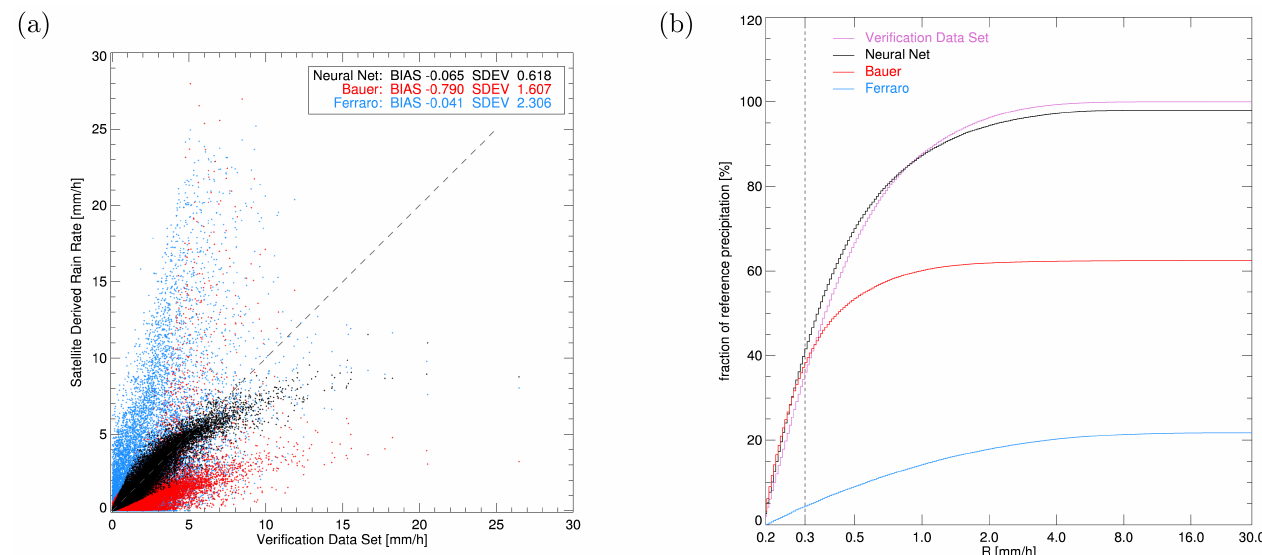
Figure 13. Comparison of di ff erent precipitation algorithms. (a) shows the retrieved precipitation rates of the neural network algorithm (black), the Bauer and Schl¨ussel (1993) algorithm (red) and the Ferraro (1997) algorithm (blue) against the precipitation rates from the verification data set. (b) shows the accumulated histogram of precipitation as the fraction of total precipitation for the di ff erent retrievals and the verification data set between 0.2mm / h and 30mm /